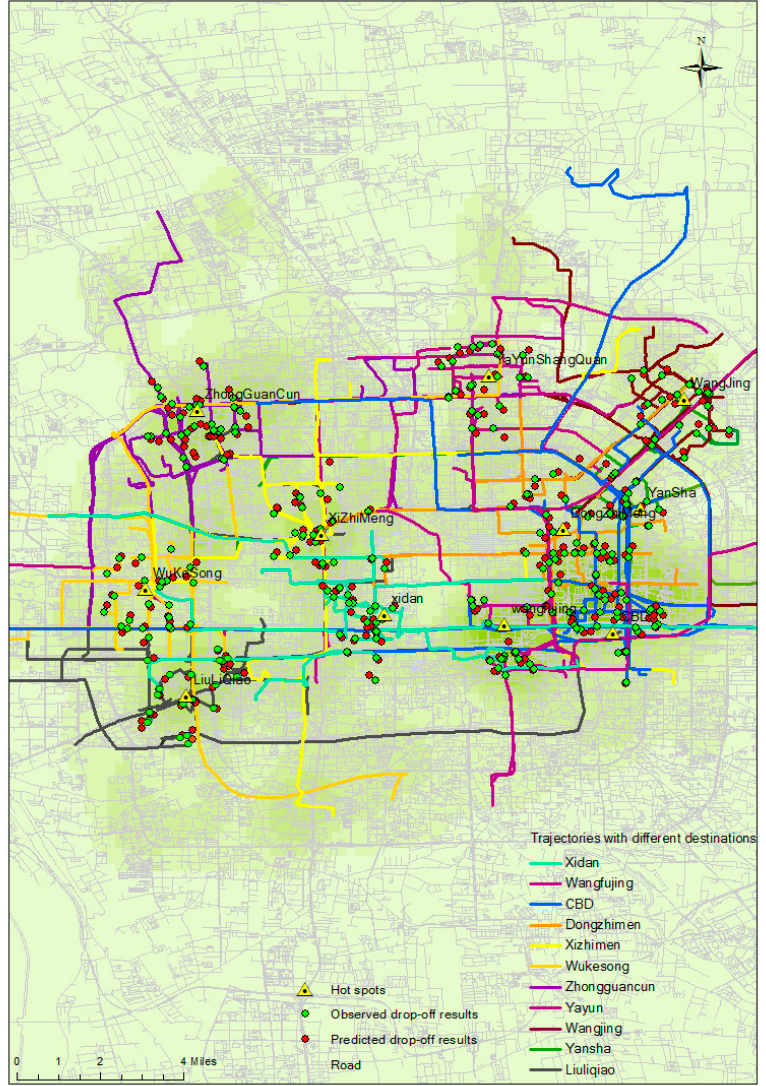
Figure 6. The number of drop-offs during different time intervals within one day.